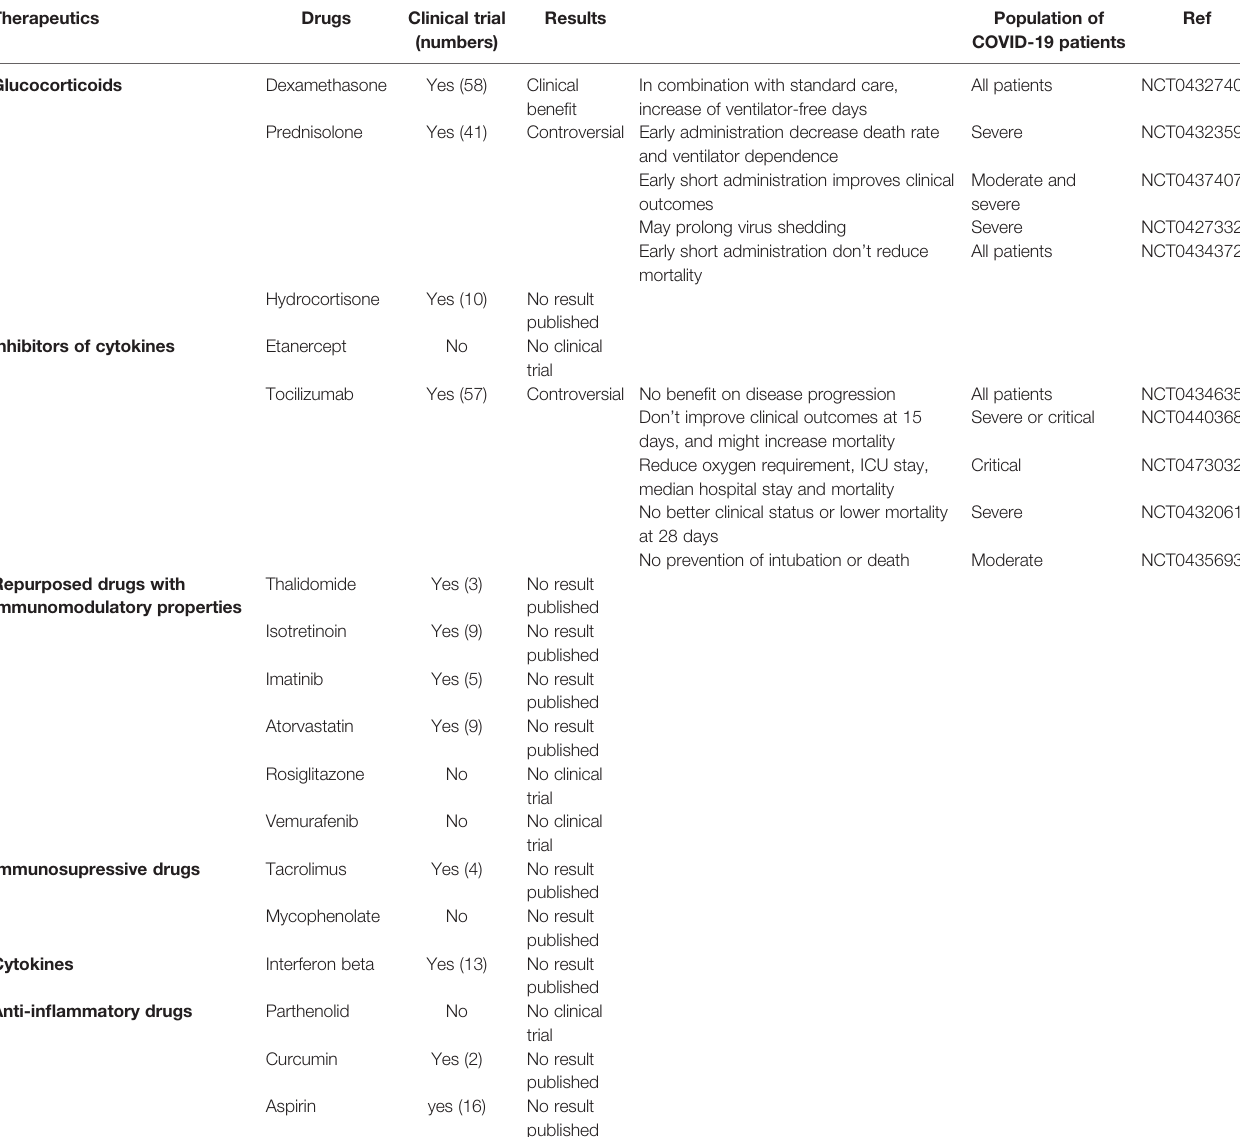
TABLE 1 | Clinical trials using drugs that could down-regulate the signature A and up-regulate the signature B (last update: June 16, 2021). Therapeutics